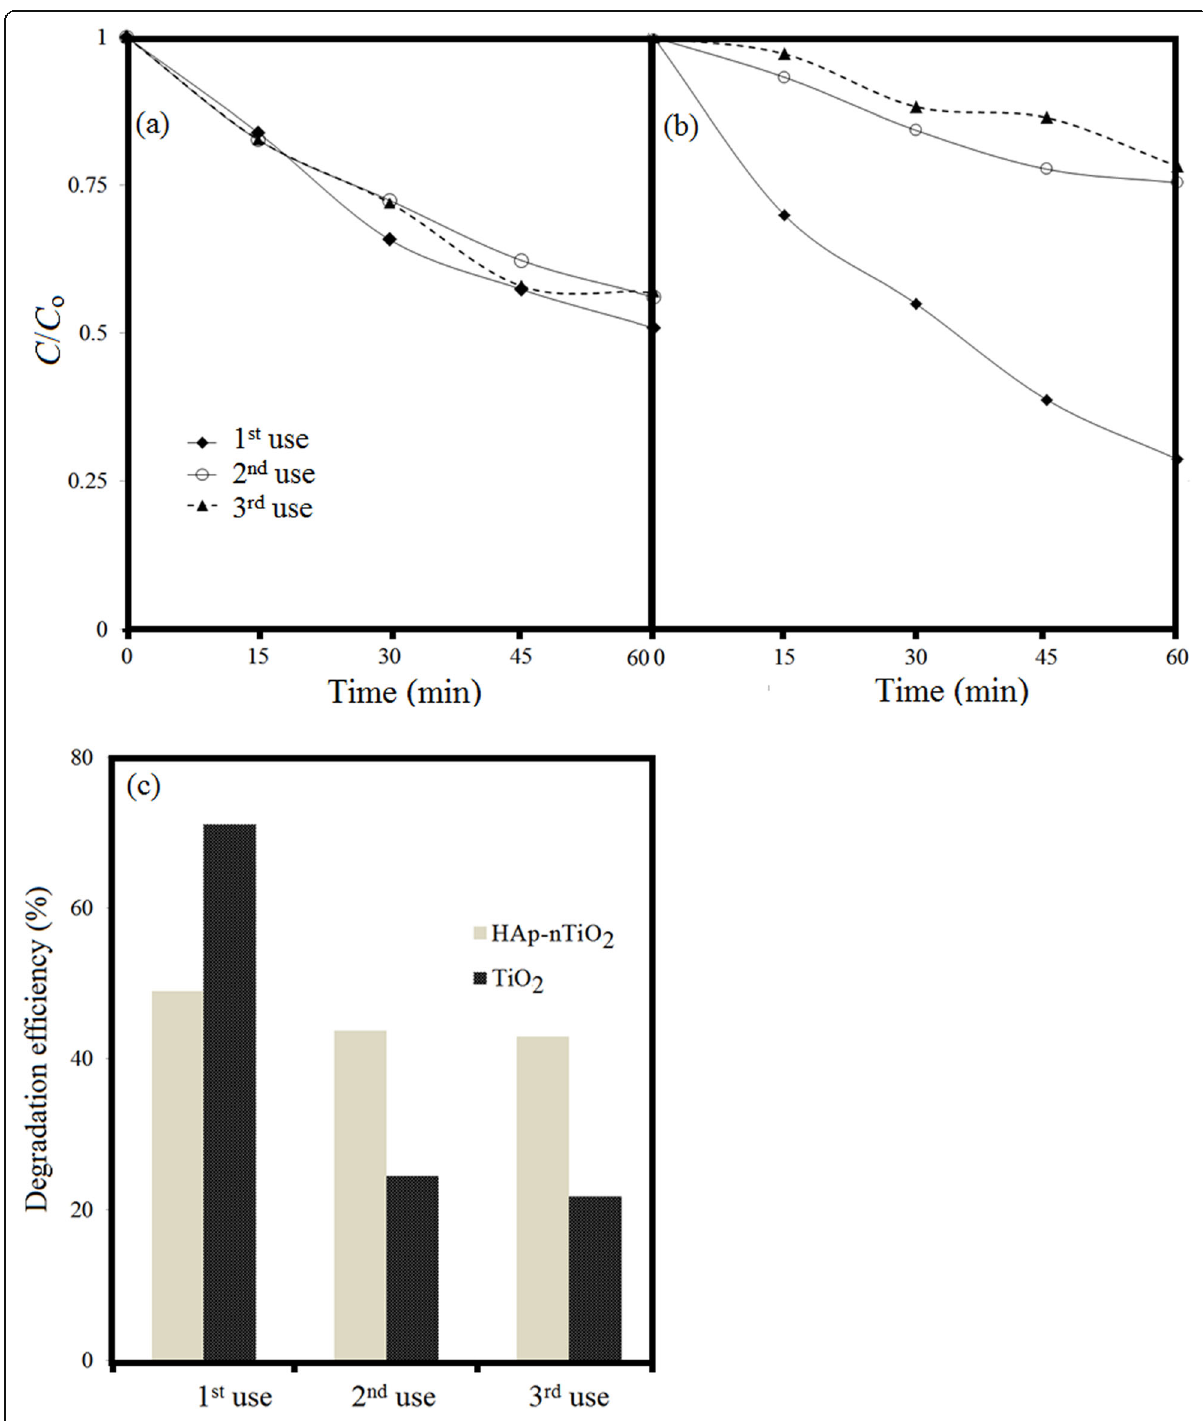
Fig. 11 a Comparison on MV photooxidation kinetics by fresh and recycled photocatalysts by HAp-nTiO 2 , and ( b ) Comparison on MV photooxidation kinetics by fresh and recycled photocatalysts by TiO 2 ( c ) Comparison on degradation efficiency of MV photooxidation by fresh and recycled photocatalysts [Initial MV concentration= 100 mg L − 1 , Time of sampling = 60 min, H 2 O 2 = 10 − 4 M, catalyst dosage = 0.25 g L − 1